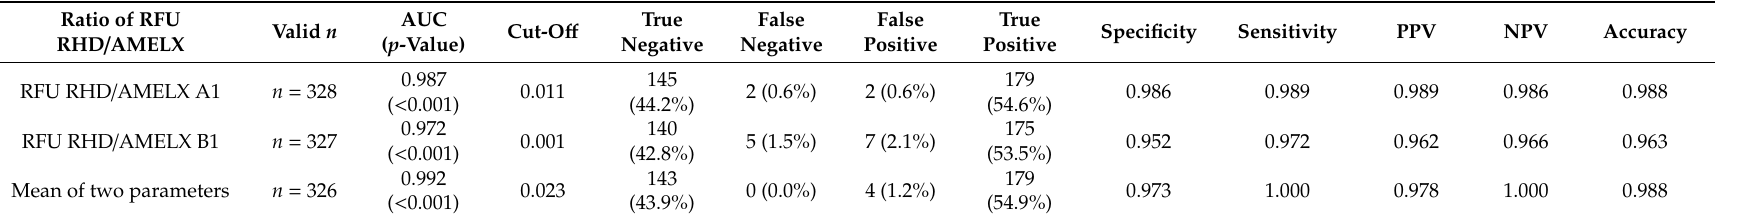
Table 5. ROC analysis of diagnostics tests and predictive power of identified cut-o ff